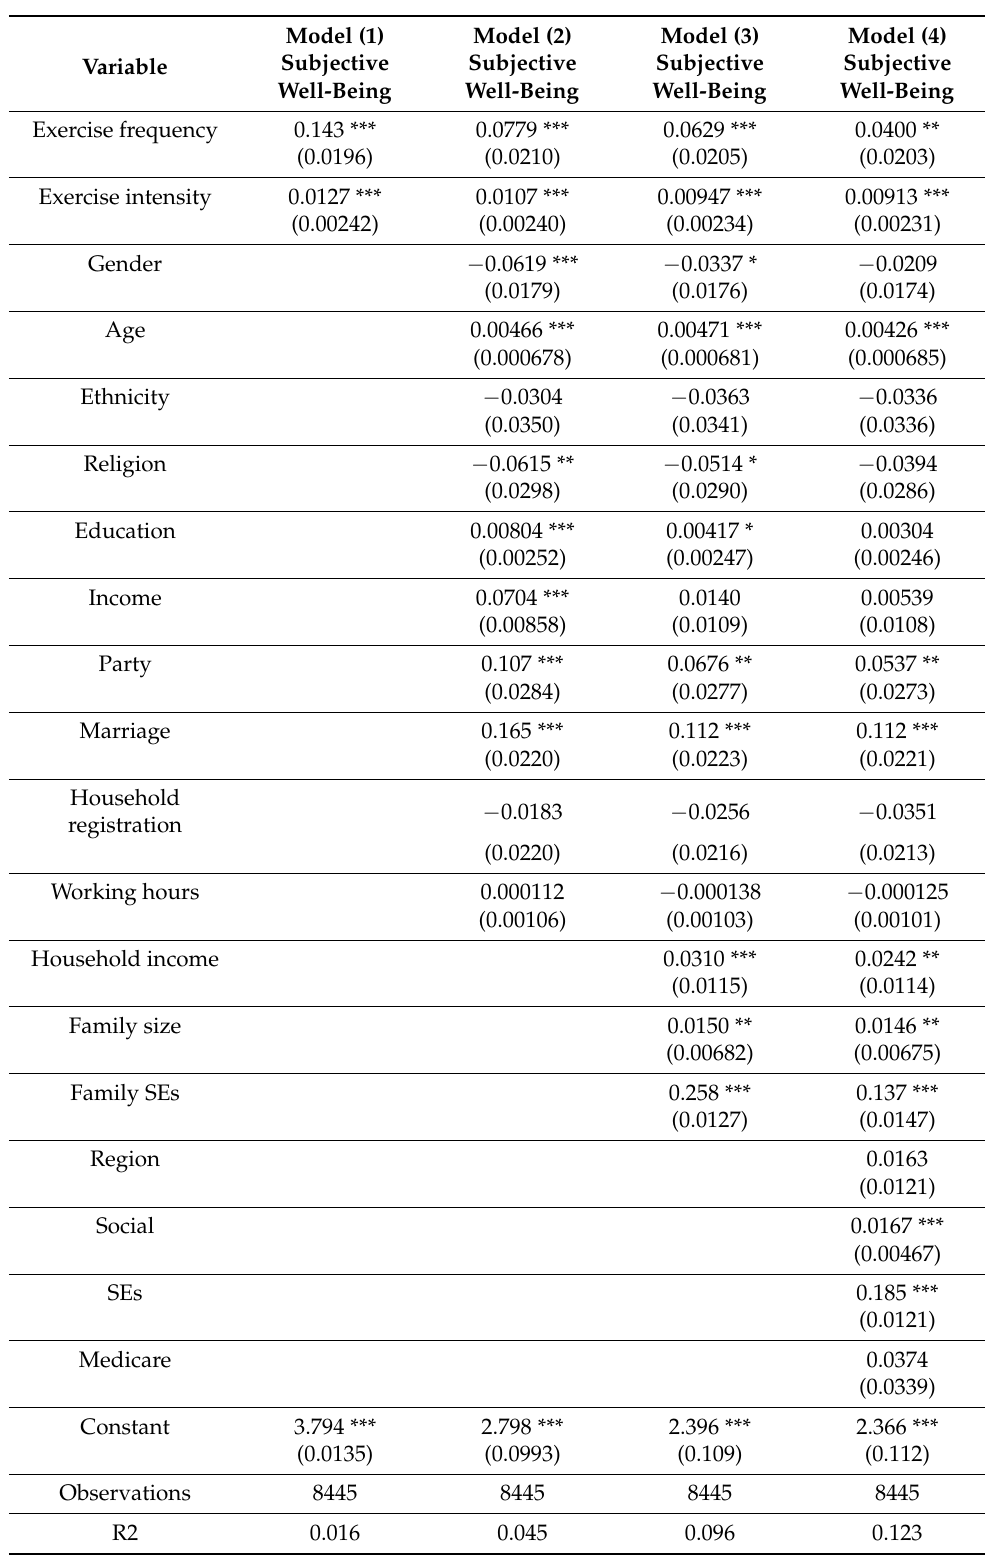
Table 2. OLS regression